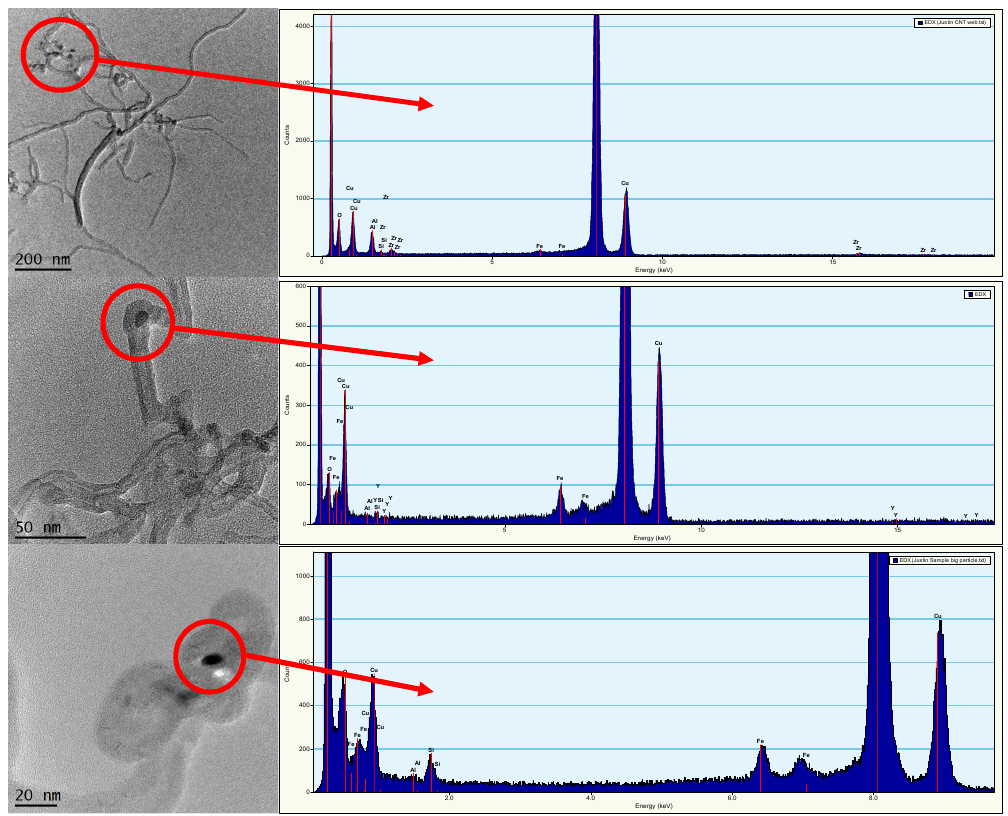
Figure 2. Transmission electron microscopy (TEM) imaging of 5% MWCNT stock solution and corresponding energy dispersive X-ray spectroscopy (EDAX) of highlighted TEM images. Dense (darker) regions on MWCNTs are residual trace metals remaining after MWCNT synthesis.